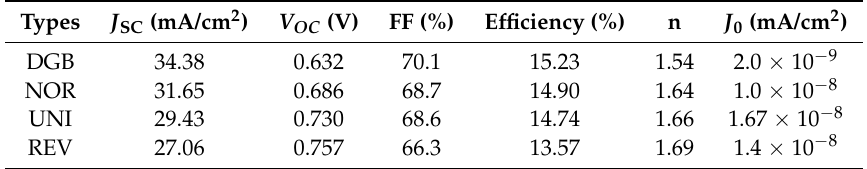
Figure 6. Bandgap energy at the position in CIGS cell for the different bandgap profiles. Table 2. Performance of the experimented and simulated solar cells with different bandgap profiles.